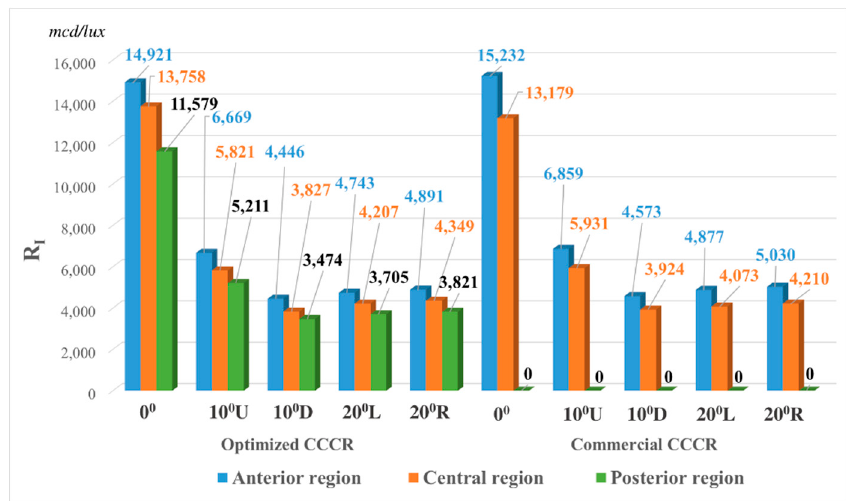
Figure 27. Comparison of coefficient of luminous intensity R I between the commercial sample and the optimized prototyped sample (region by region).